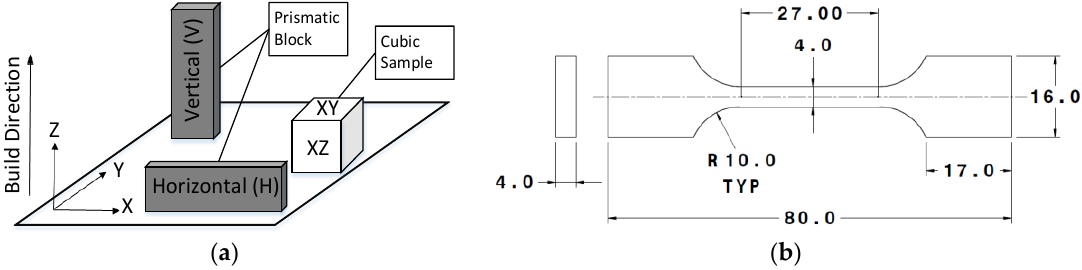
Figure 1. ( a ) LPBF samples and ( b ) uniaxial tensile testing samples (dimensions in mm).